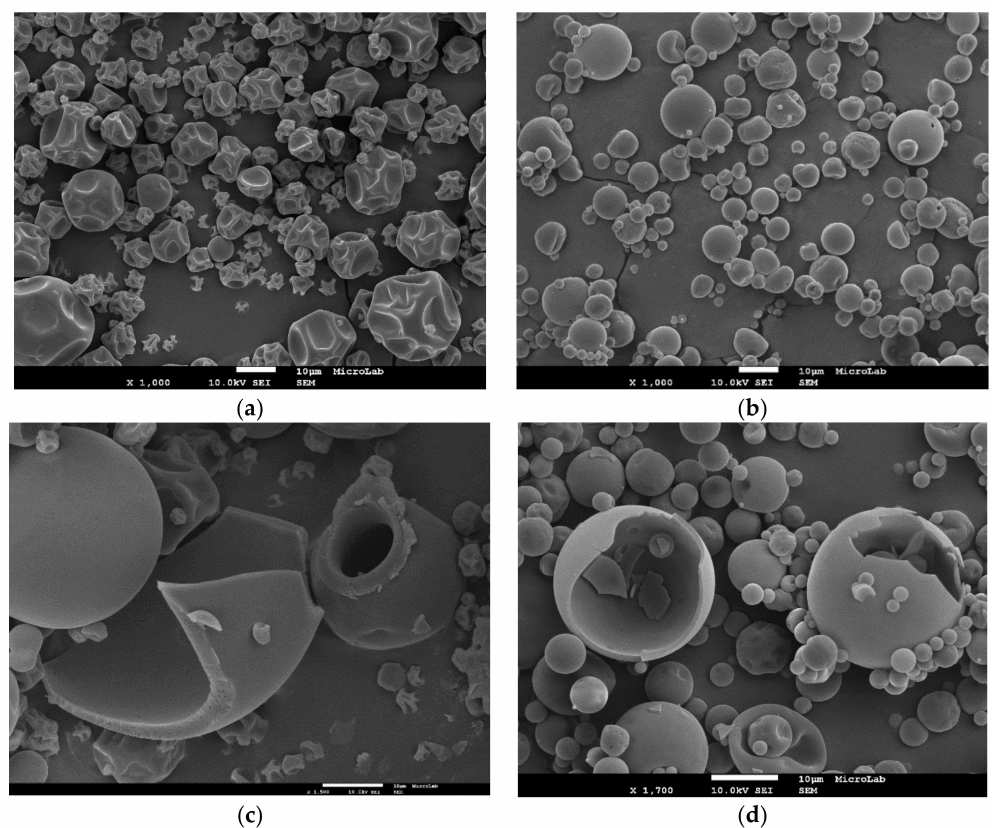
Figure 2. SEM images of microcapsules: ( a , c ) arabic gum (Magnification × 1000 and × 1500) and ( b , d ) inulin (Magnification × 1000 and ×